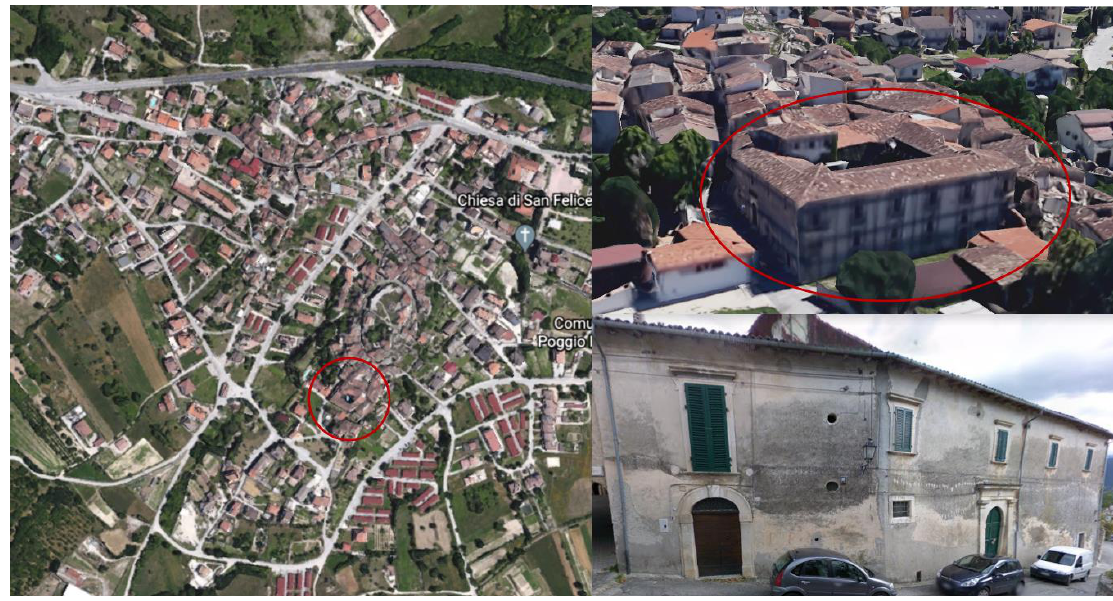
Figure 2. Galeota Palace in Poggio Picenze (AQ) (Google Earth) .